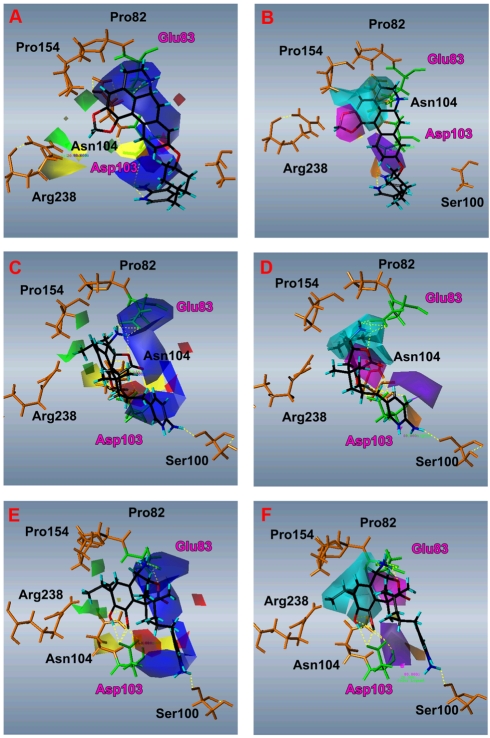
CoMFA (left) and CoMSIA (right) models of the latest N1 conformation with TCM candidates and Tamiflu® at 20 ns simulation time within the H1 protein binding site.Respective CoMFA and CoMSIA models of Xylopine_2 (A, B), Rosmaricine_14 (C, D), and Rosmaricine_15 (E, F). Contours in CoMFA represent the following features: favors bulky substituent (green), disfavors bulky substituent (yellow), favors electropositive groups (blue), and disfavors electropositive groups (red). Features in CoMSIA model include: hydrophobic (cyan), hydrophilic (yellow), favorable H-bond acceptor (magenta), unfavorable H-bond acceptor (green), H-bond donor (orange), disfavor H-bond donors (purple).